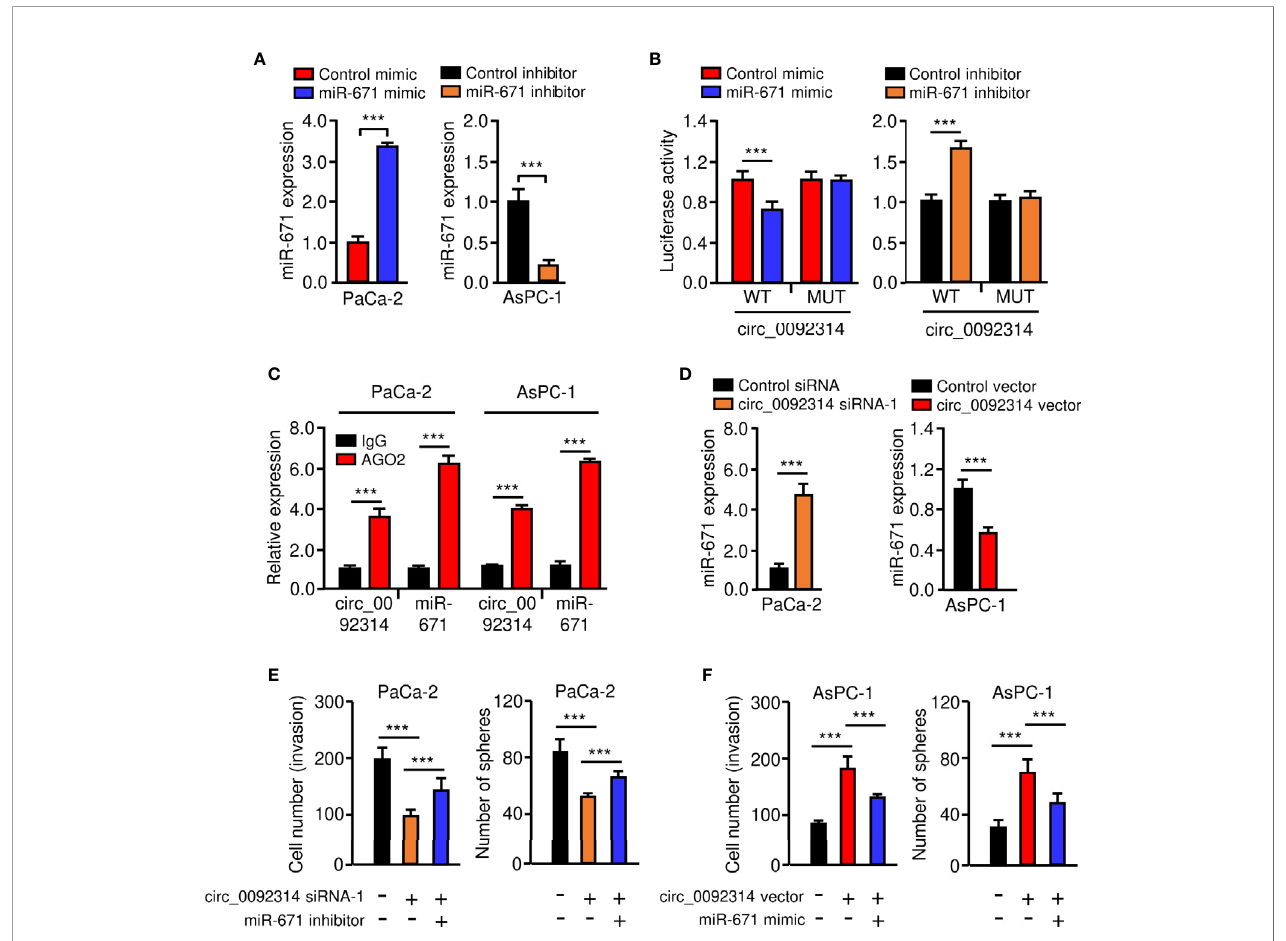
FIGURE 5 | Circ_0092314 binds to miR-671 and suppresses its expression in PAAD cells. (A) qRT-PCR analysis of miR-671 in PAAD cells following overexpression or knockdown of miR-671. (B) The activities of circ_0092314 reporter containing wild-type (WT) or mutant (MUT) binding sites were determined using luciferase assay following co-transfection with miR-671 mimic or miR-671 inhibitor. (C) RIP assay was performed in PaCa-2 or AsPC-1 cells. The levels of circ_0092314 and miR-671 were detected by qRT-PCR assay. (D) The expression of miR-671 in PAAD cells following knockdown or overexpression of circ_0092314. (E) Cell invasion (left) and sphere formation (right) assay in PaCa-2 cells transfected with (or without) circ_0092314 siRNA, along with (or without) miR-671 inhibitor. (F) Cell invasion (left) and sphere formation (right) assay in AsPC-1 cells transfected with (or without) circ_0092314 vector, along with (or without) miR-671 mimic. *** P